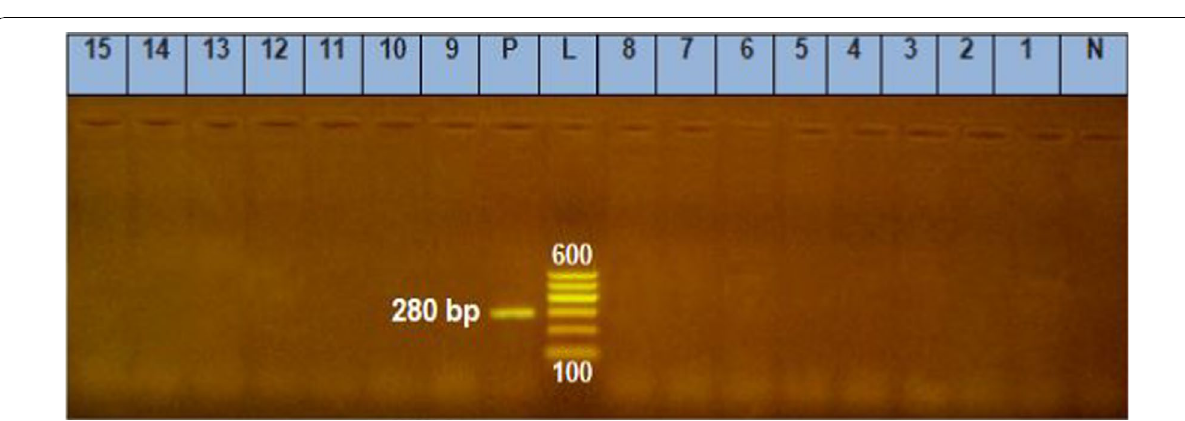
Fig. 7 Agarose gel electrophoresis showing amplification product of 280 bp of VIM . Lane L : Ladder (Marker) 100–1000 bp plus DNA ladder. Lane P : control positive. Lane N : control negative. Lane 1–15 : examined